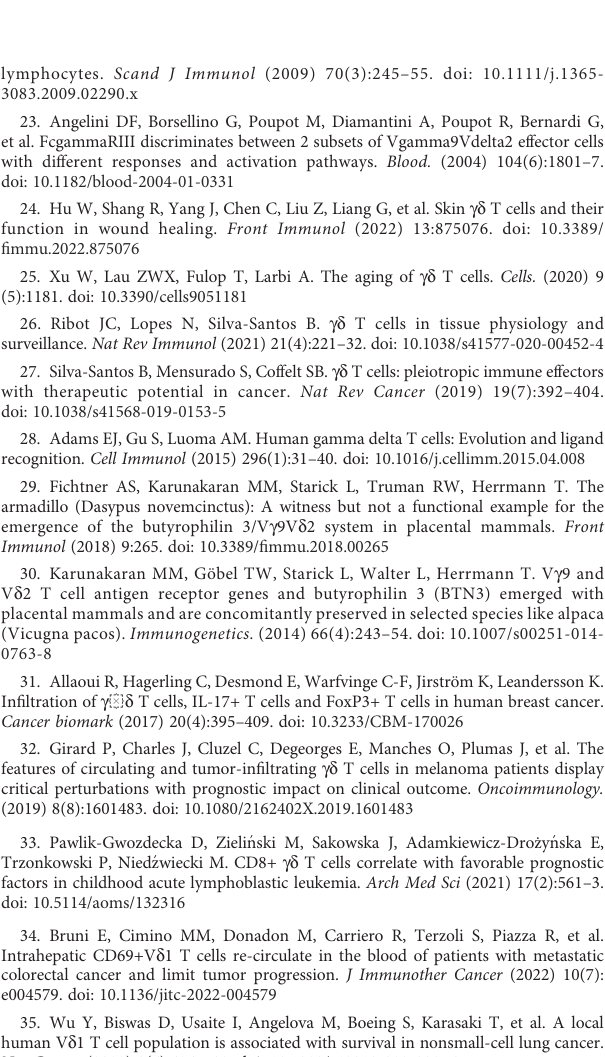
(Figure 2B; Table 2), in whichboth responses and treatment types weredifferent between blood and solid tumors (Table 3; n = 138). This may emphasize the importanceof different gd T-cell therapy strategies on treatment